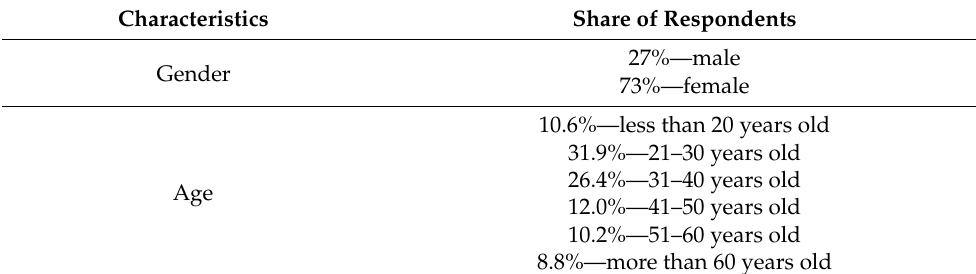
Table 1. Demographic characteristic of respondents ( n = 216 Moscow